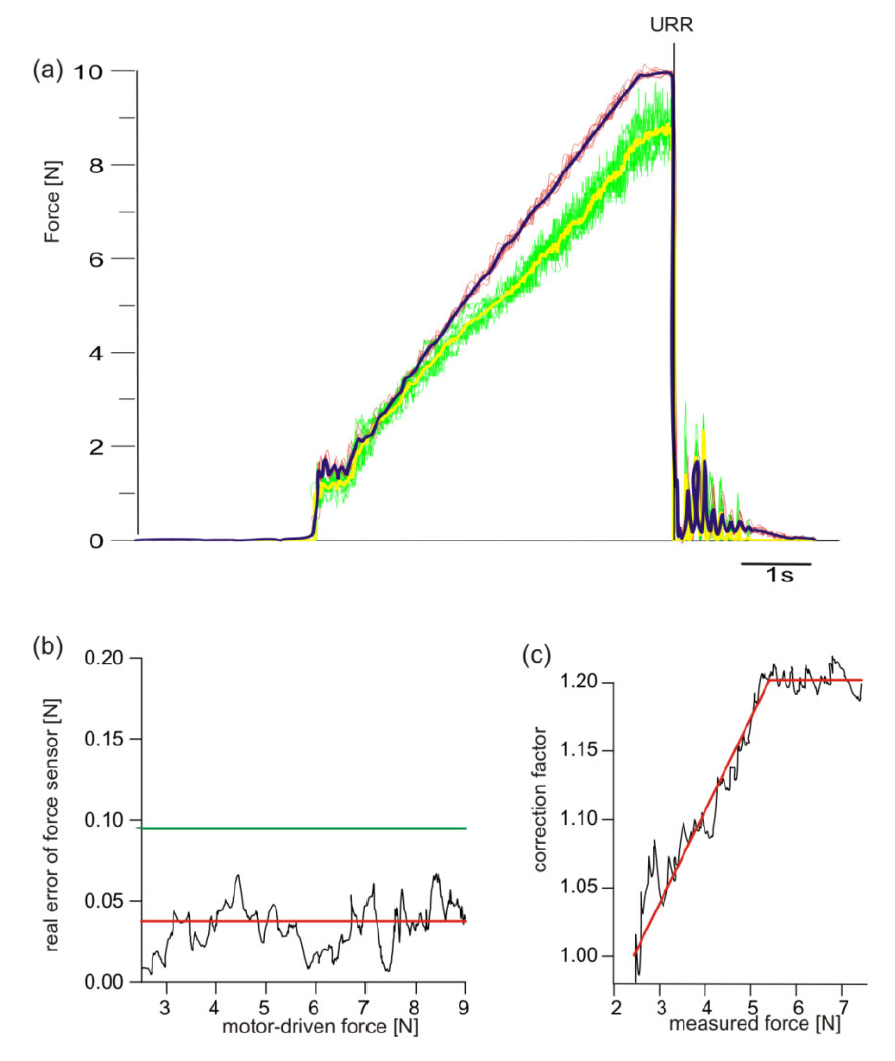
Figure 2. Simulation of force change during the “pick the raspberry” task. (a) Motor- driven forces of ten repetitions (red lines) and mean value (blue line) are shown as well as the measured forces (green lines) and their mean value (yellow line). (b) Real error of force sensor over motor-driven force with mean value (red line) and upper 1%-confidence band (green line). (c) Compensatory correction function for measured forces